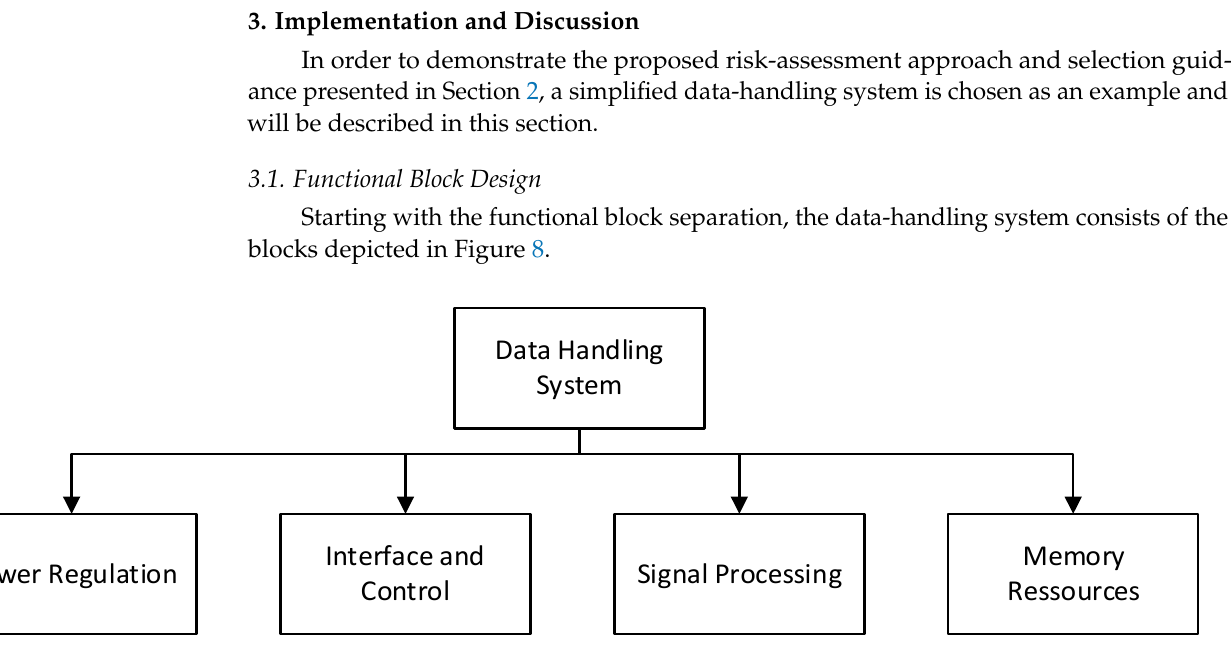
Figure 8. Simplified functional block design of a data-handling system.